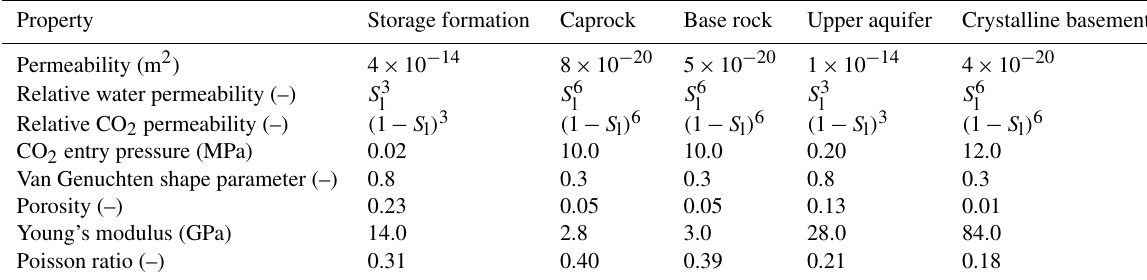
Table A3. Material properties of the intact rock types included in the model shown in Figs. 6 and 7.